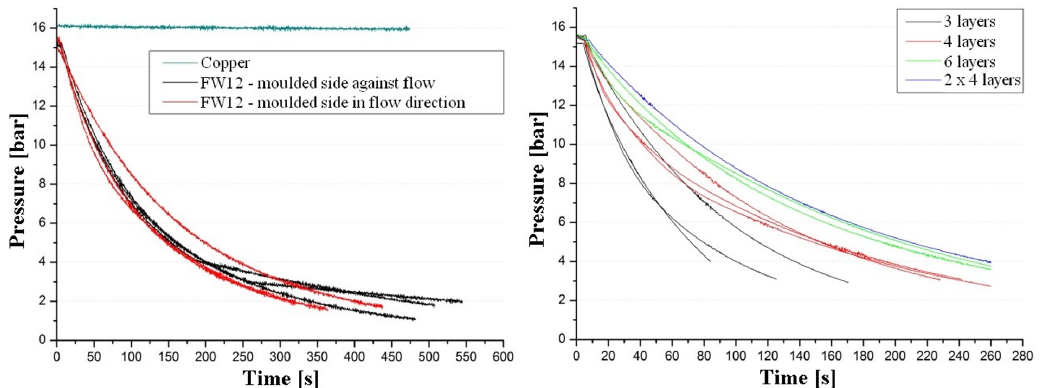
Figure 15. Pressure curves determined in leak tests, ( left ) in relation to the reference sample made of copper and ( right ) in comparison of different layer structures.